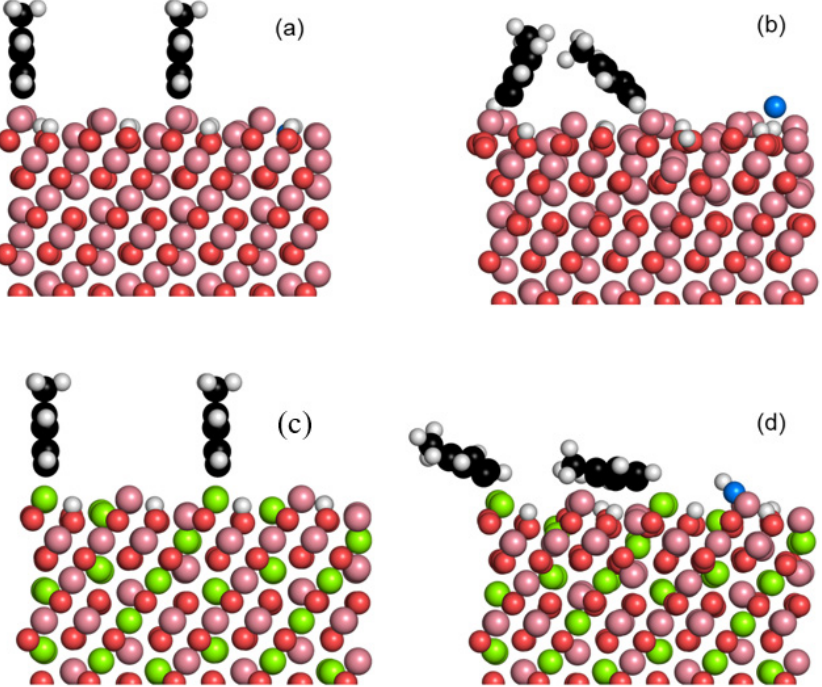
Figure 5. Snapshots of initial and final (10 ps) configurations of toluene adsorbed on hydroxylated Co 3 O 4 (111) ( a , b ) and MgCo 2 O 4 (111) ( c , d ) surfaces. Mg: green, Co: pink, slab oxygens: red, vacant oxygen: blue, carbon: black, hydrogen: white.